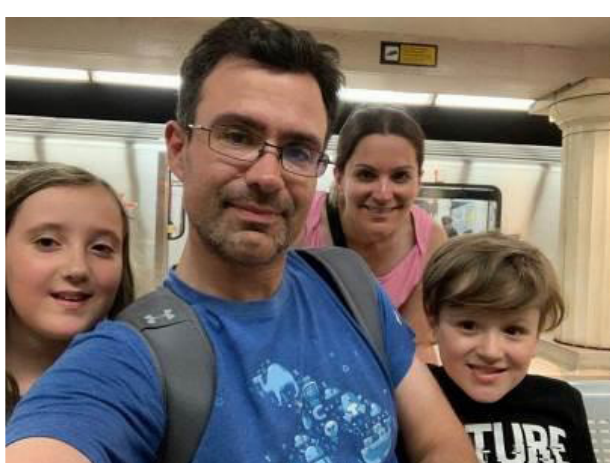
Fig. 14 - Tomas Salerno’s son Mark, grandchildren Amara and Riley, and daughter Kim.